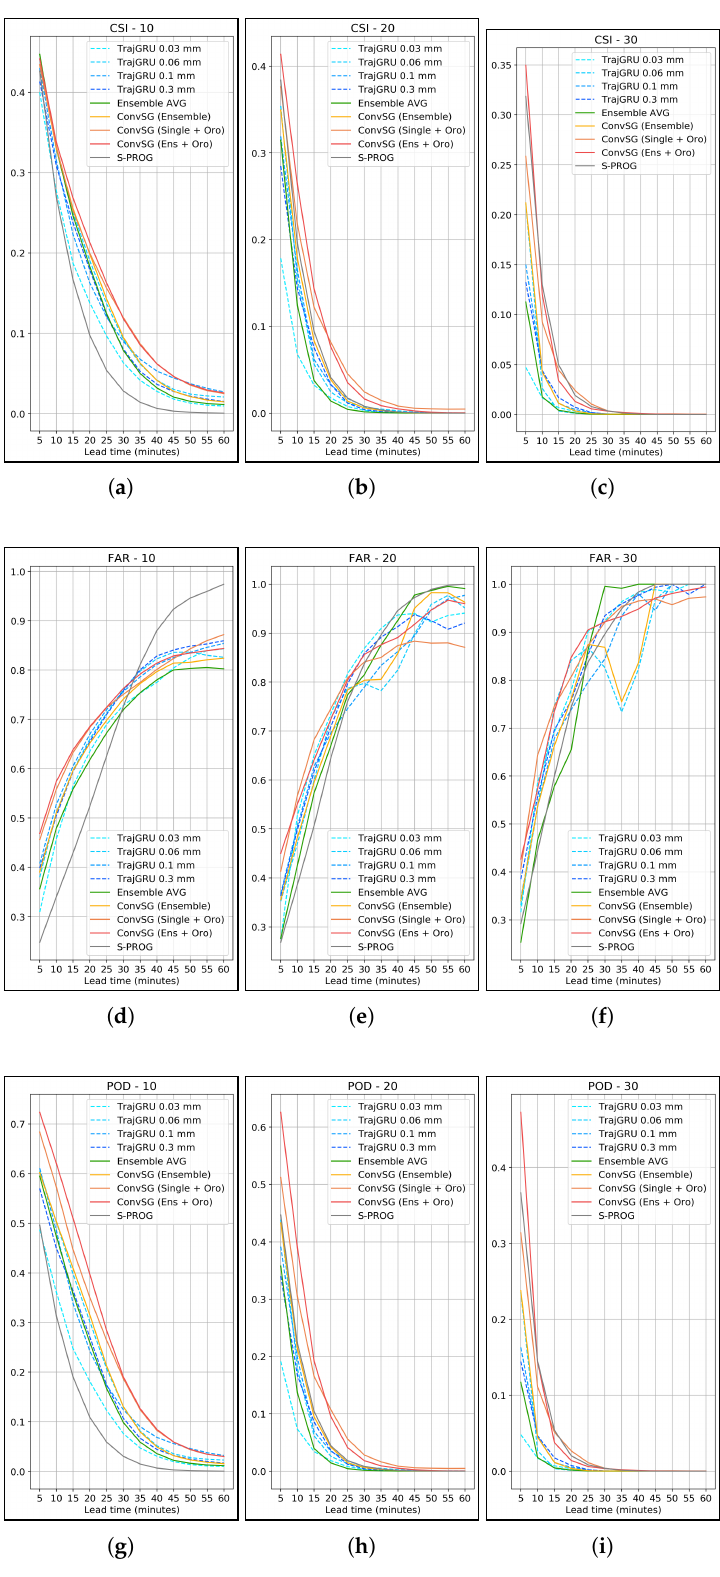
Figure 11. Comparison of ESG, ensemble members and average for CSI, FAR, and POD scores on heavy and severe rain-rates (10, 20, and 30 mm/h): ( a ) CSI-10; ( b ) CSI-20; ( c ) CSI-30; ( d ) FAR-10; ( e ) FAR-20; ( f ) FAR-30; ( g ) POD-10; ( h ) POD-20; and ( i )